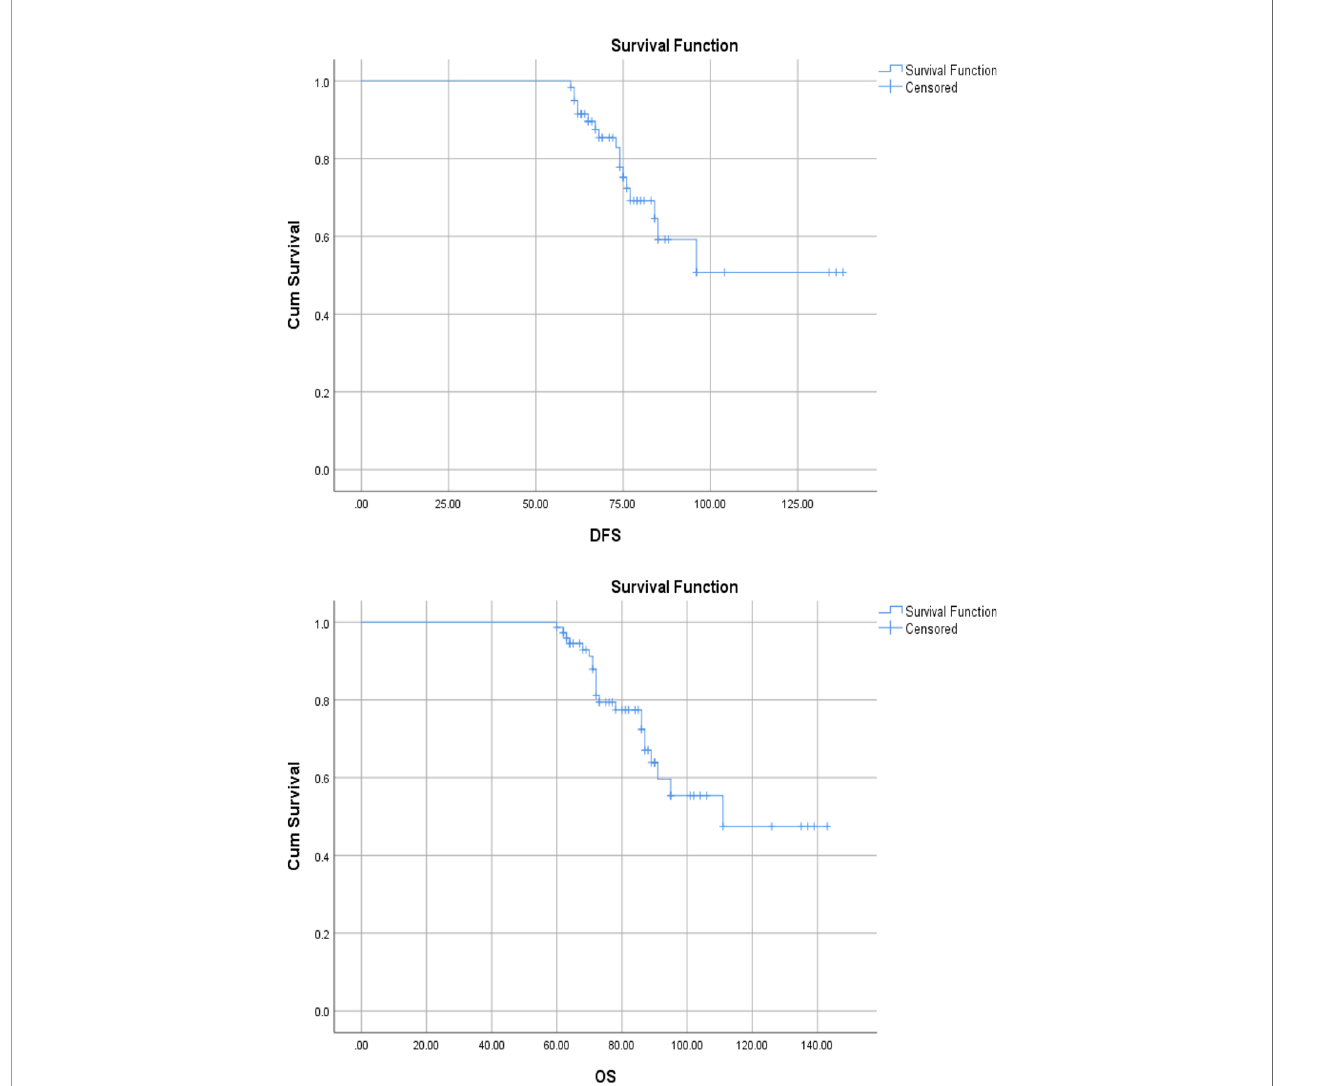
FIGURE 2 | Kaplan – Meier curve showing 5-year disease-free and overall